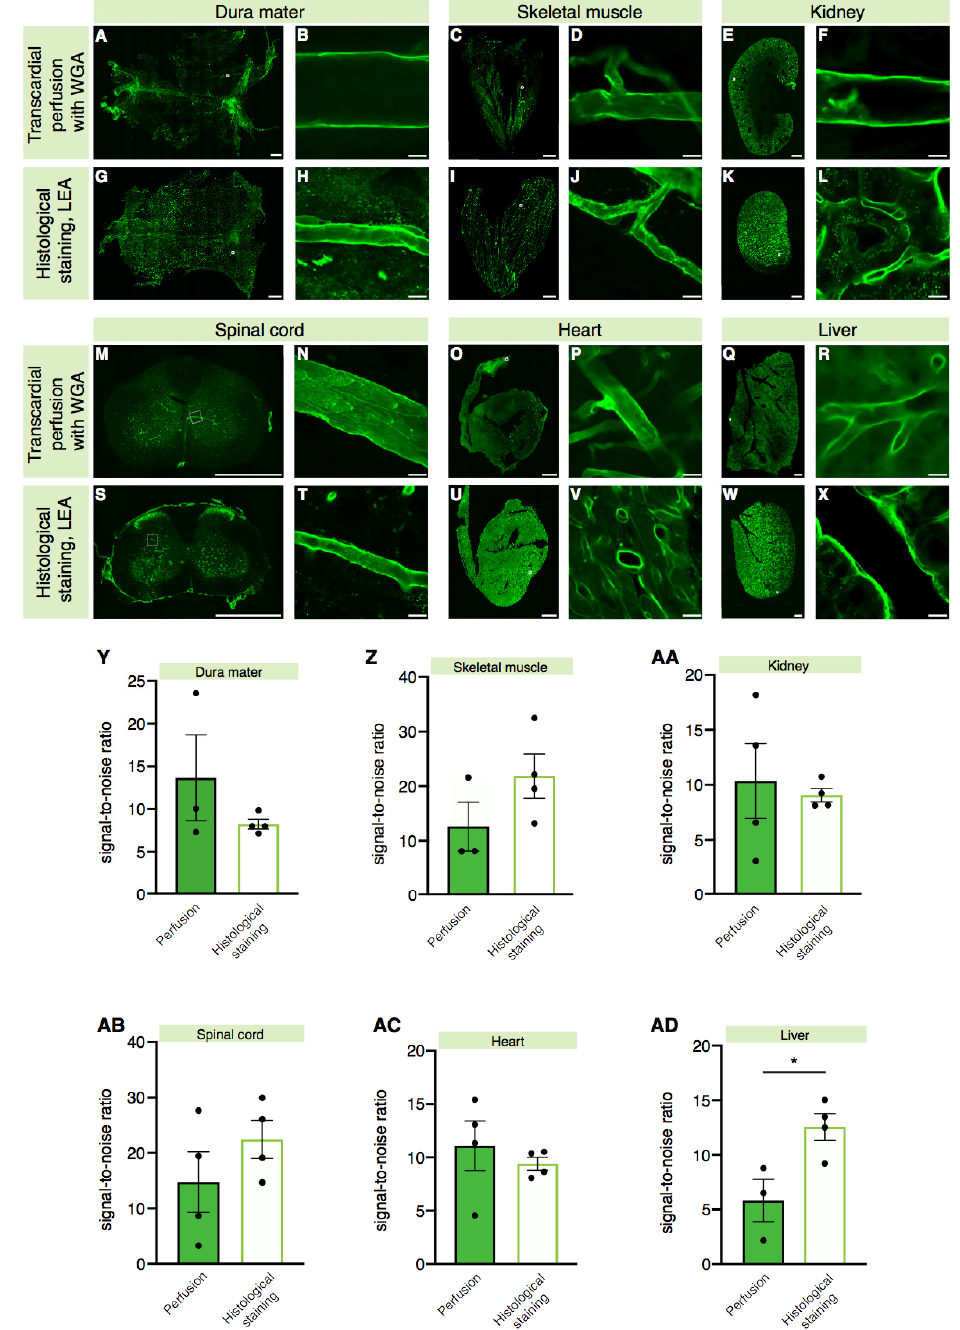
Figure 3. Comparison of different methods of labeling blood vessels in various organs with lectins: WGA intravascular delivery during terminal perfusion vs. LEA histological staining on free-floating sections. ( A – X ) Representative images of the whole-mount dura mater meninx, skeletal muscle, kidney, spinal cord, heart, and liver tissues of the mice intracardially perfused with the WGA lectin (concentration: 50 µg/mL) compared with those histologically stained with the LEA lectin. White squares indicate the point where the high magnification images of the blood vessels used for the quantification were acquired from. Scale bars: 1000 µm for low magnification images, 10 µm for high magnification images. ( Y – AD ) Quantification of the signal-to-noise ratio values of the two methods in different organs (dura mater: Welch’s t -test, p = 0.3955; skeletal muscle: Mann–Whitney U test, p = 0.2286; Kidney: Welch’s t -test, p = 0.7319; spinal cord: unpaired t -test, p = 0.2778; heart: unpaired t -test, p = 0.5096; liver: unpaired t -test, p = 0.0272); n = 3 to 4 mice for the 50 µg/mL WGA perfusion group and n = 4 mice for the LEA histological staining group. * = p < 0.05.